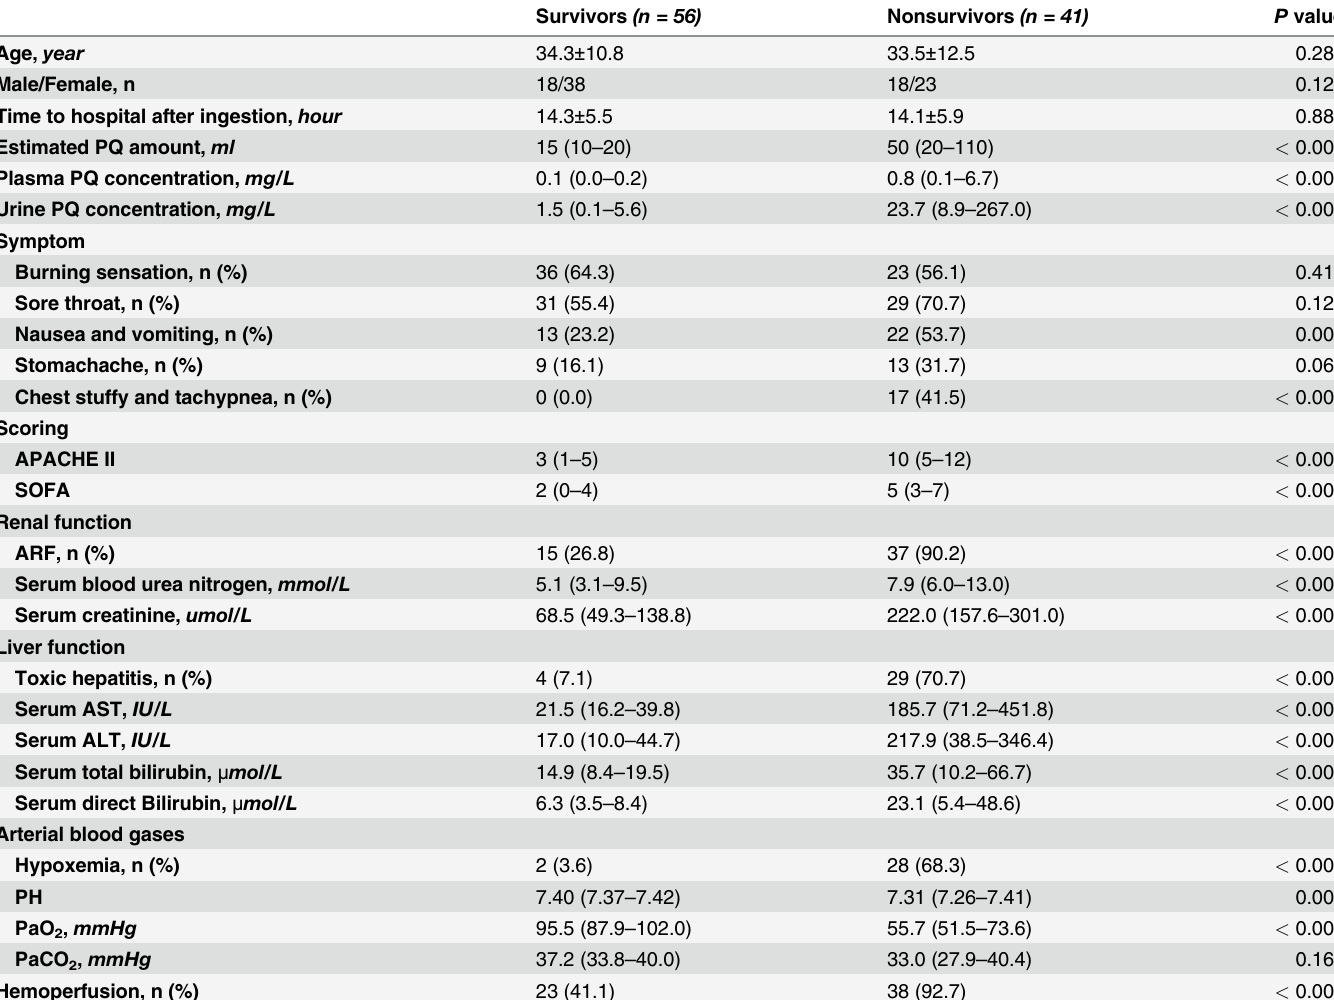
Table 1. Demographic and Clinical Data of Patients during the first 5-day of PQ